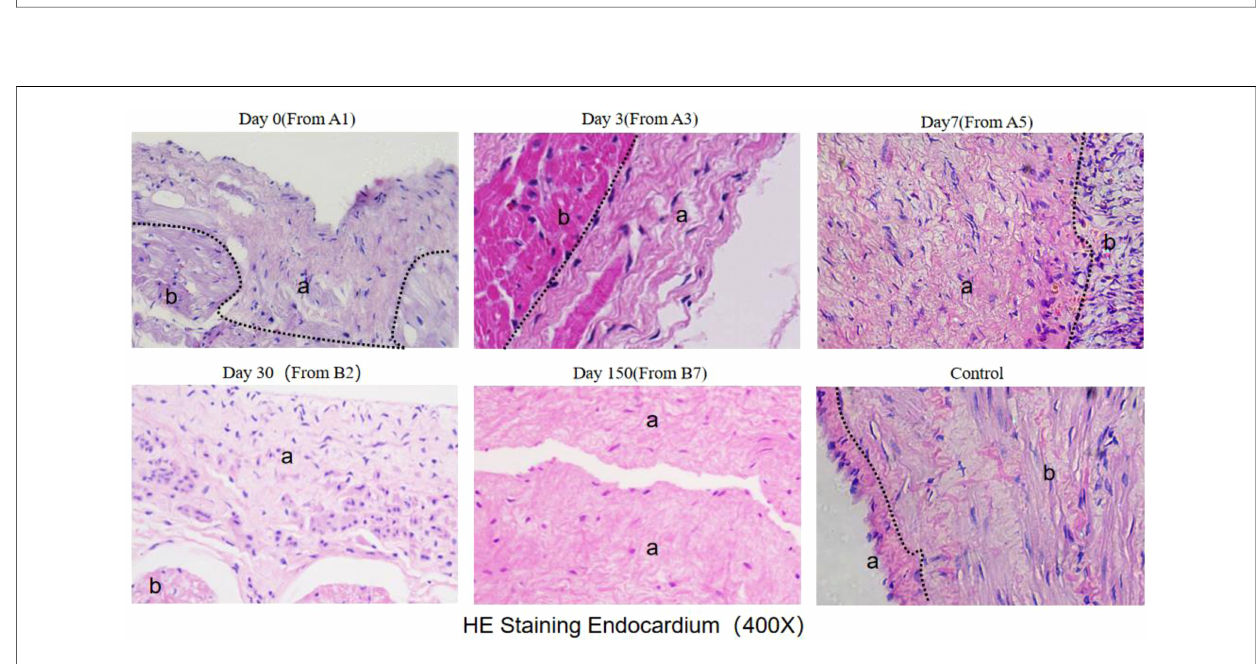
FIGURE 8 He staining results (observed under 400X microscope) The black dotted line marks the boundary between myocardial intima and myocardial cells. a indicates the intima layer, and b indicates the myocardial